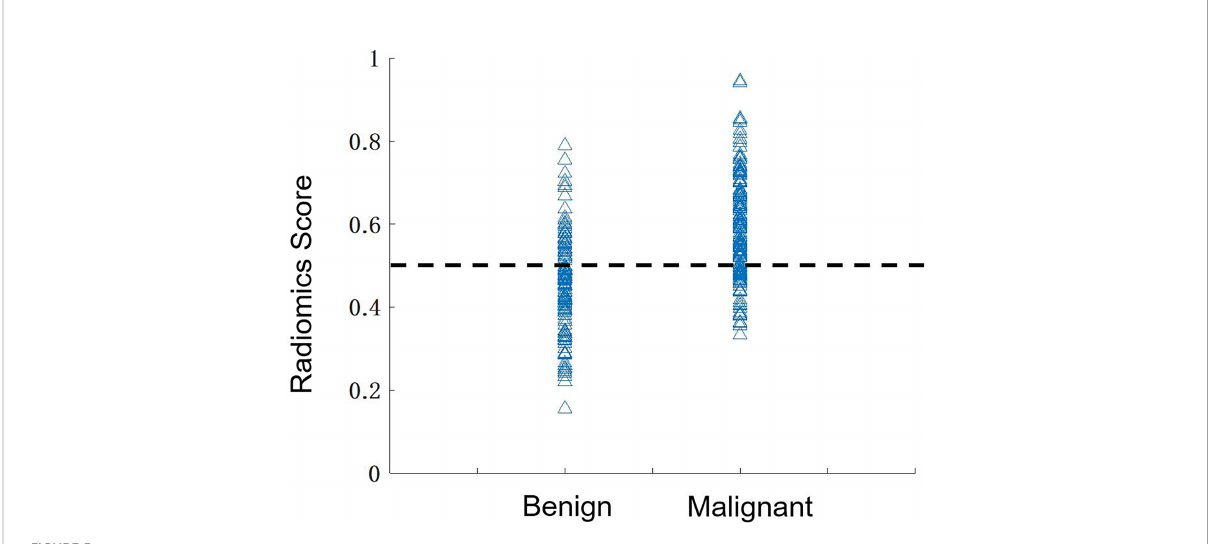
FIGURE 5 The distribution of the radiomics scores predicted by using the combined model in the benign and malignant groups. By using the threshold of 0.5 as the cut-off value, there are 136 true-positive, 84 true-negative, 39 false-negative, and 39 false-positive cases, with an overall accuracy of 220/298 = 74%.